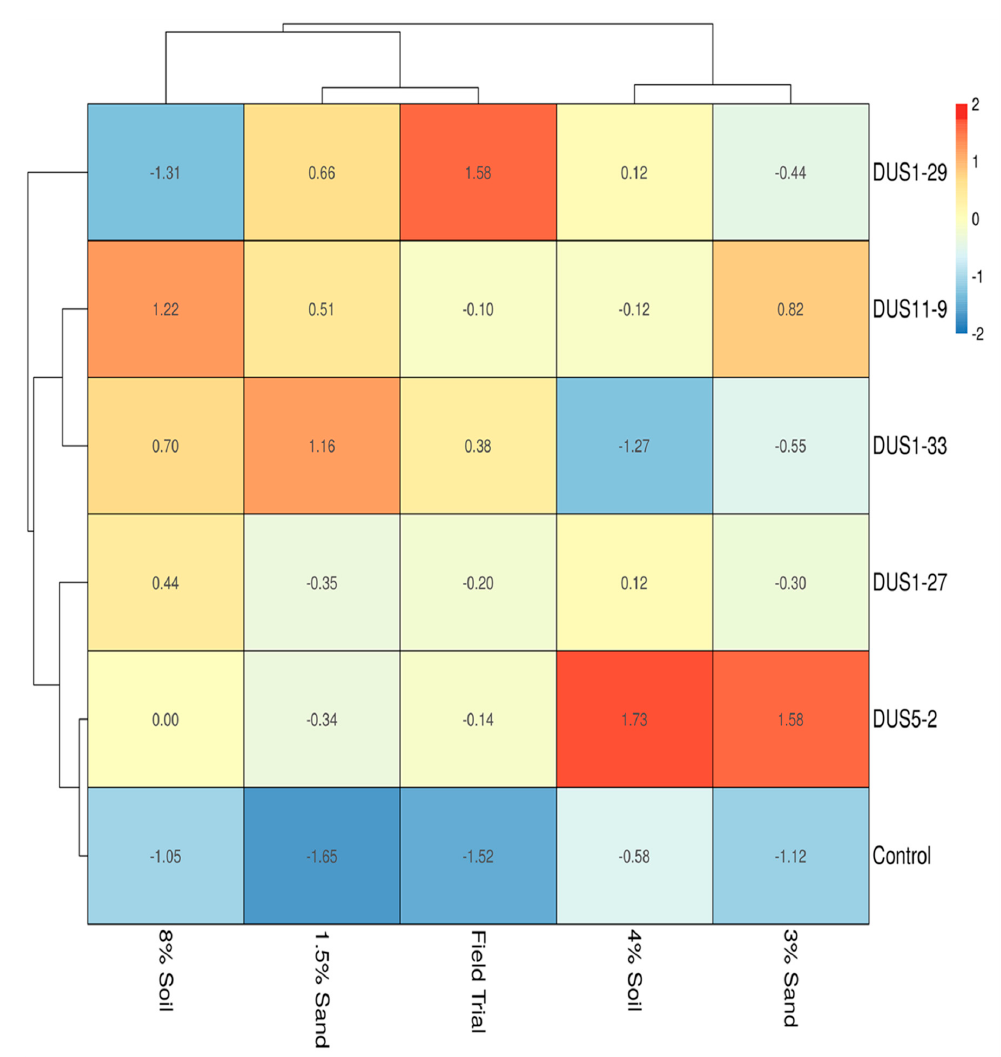
Figure 9. Principal component analysis of the effect bacterial isolates have on B. napus L. total plant dry biomass for plants grown in either sand-based systems with 3% water activity (3% sand), sand- based system with 1.5% water activity (1.5% sand), soil-based system and 8% water activity (8% soil), soil-based system with 4% water activity (4% soil), or field conditions (Field Trial). Ranking is